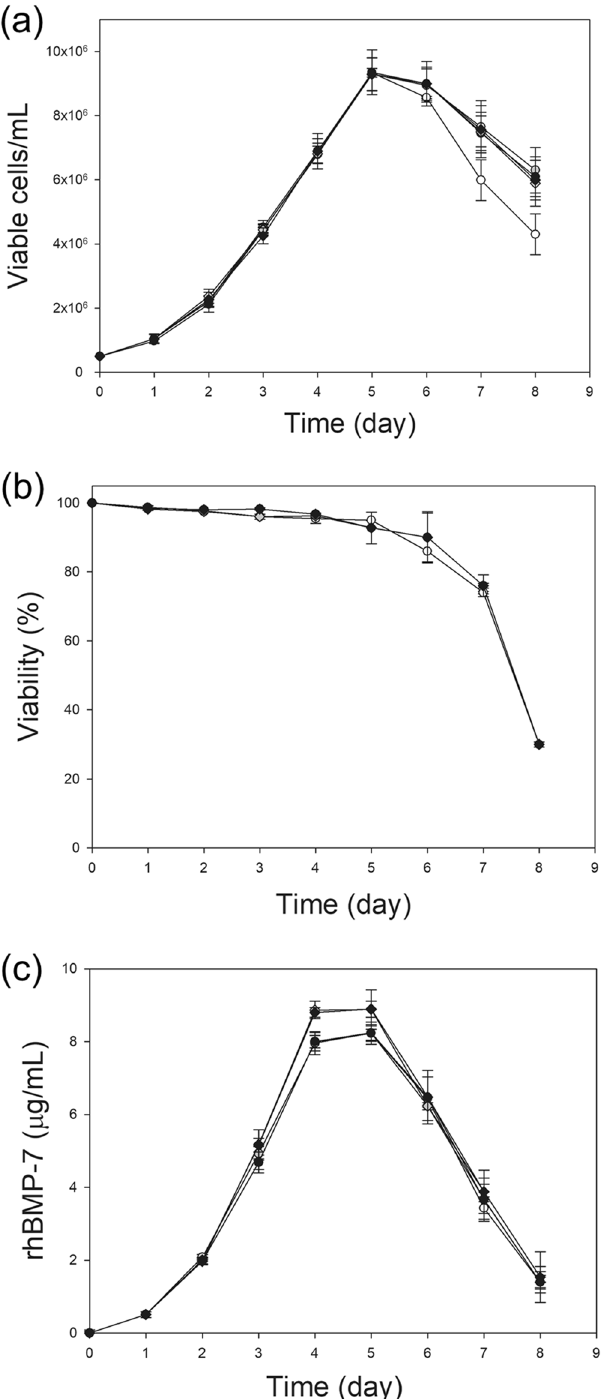
Figure 8. Supplementation of DS or heparin in CHO-BMP-7 cells cultures. Profiles of ( a ) cell growth, ( b ) viability, and ( c ) rhBMP-7 concentration during cultures supplemented with DS or heparin. No supplementation (white circle), supplementation with 0.1 g/L heparin (gray square), 0.2 g/L heparin (black square), 0.5 g/L DS (gray diamond), and 1.0 g/L DS (black diamond). The error bars indicate standard deviations calculated from the data of three independent